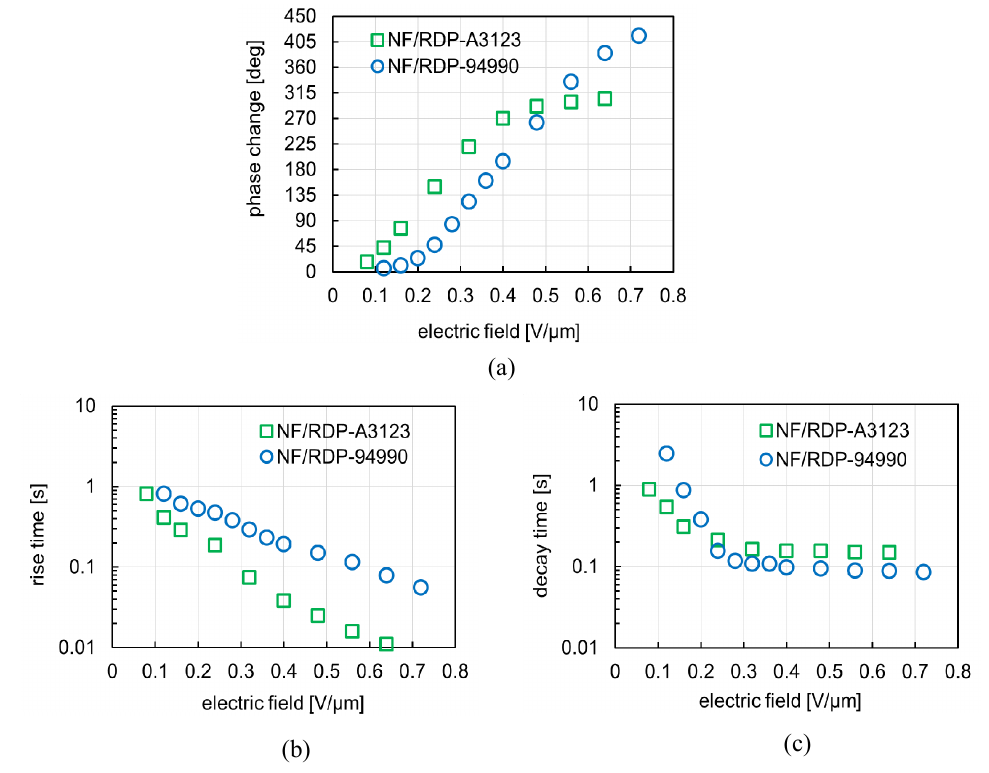
Figure 12. Electric field dependencies of ( a ) phase change, ( b ) rise time, and ( c ) decay time in NF / RDP-94990 complex and NF / RDP-A3123